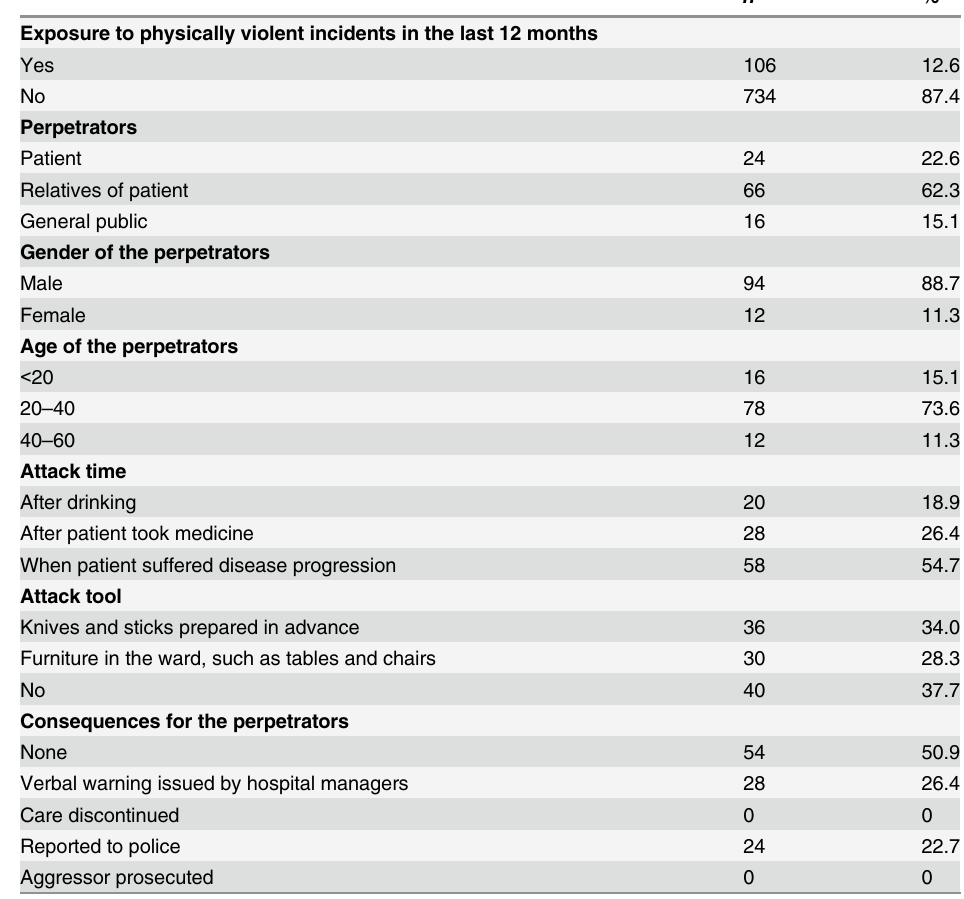
Table 2. Prevalence (%) and characteristics of physical violence in township hospitals of Heilongjiang province, and consequences for the perpetrators. Exposure to physically violent incidents in the last 12 months